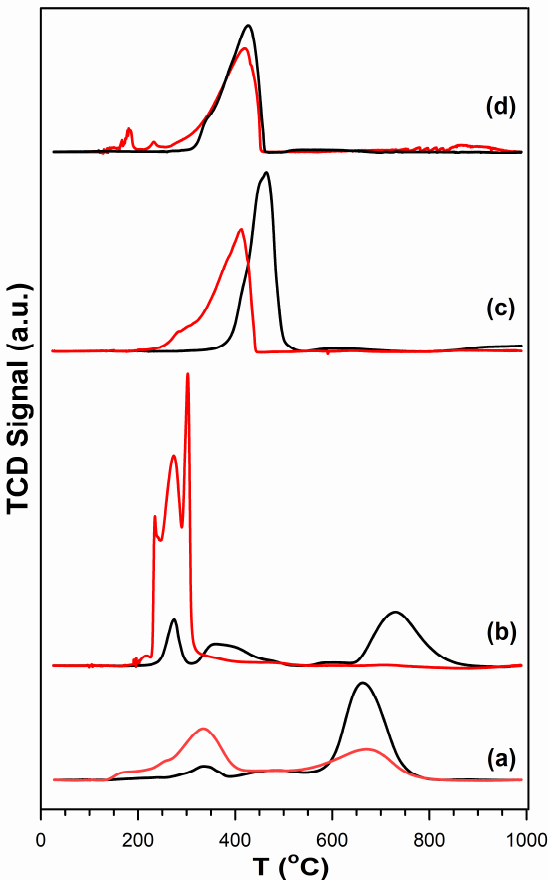
Figure 3. TPR profiles of ( a , c ) calcined and ( b , d ) uncalcined 12% Co/SiO 2 catalysts prepared with ( a , b ) cobalt acetate and ( c , d ) cobalt chloride, including (black) unpromoted and (red) 0.5% Pt-promoted catalysts.